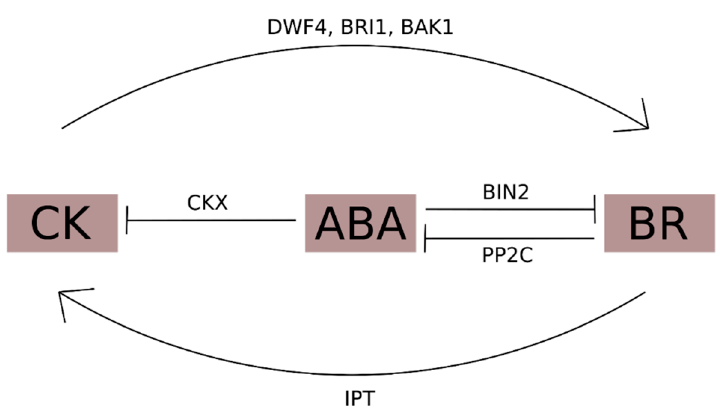
Figure 5. A putative interplay between brassinosteroid (BR), cytokinin (CK), and abscisic acid (ABA). ABA is responsible for inhibiting BR effects during stress conditions by upregulating BIN2 (BRASSINOSTEROID-INSENSITIVE 2), a major negative regulator of BR signaling, whereas BR is responsible for inhibiting ABA effects during growth processes through PP2C (PROTEIN PHOSPHATASE 2C), a major negative regulator of Snark proteins (positive regulators of ABA signaling). ABA is also responsible for inhibiting CK signaling by upregulating CKX (CK oxidases/dehydrogenases), which play a major role in inactivating bioactive CKs. Despite ABA’s role, BR and CK present positive interactions. While CK upregulates BR biosynthetic ( DFW4 ) and signaling ( BRI1 , BAK1 ) genes, BR upregulates IPT (isopentenyltransferases), which are major enzymes responsible for the biosynthesis of bioactive CKs.